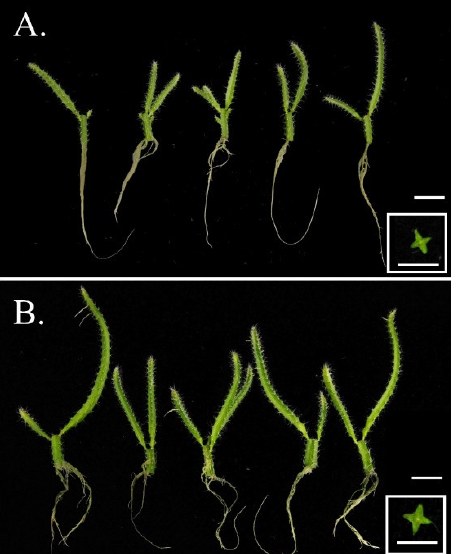
Figure 4. Plantlets of Hylocereus polyrhizus ‘Da Hong’ cultured ( A ) on Murashige and Skoog (MS) medium and ( B ) on activated charcoal (AC)-supplemented MS medium. Profiles in the white square frame are plantlet transections, showing that plantlets grown on the AC-supplemented MS medium were succulent. Bar = 2 cm; bar inside white square = 1 cm.